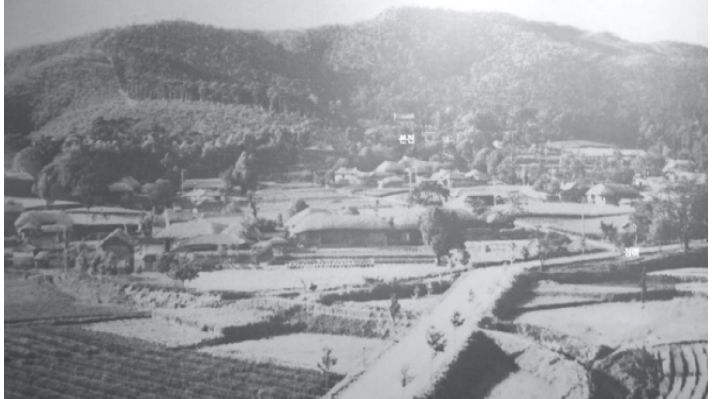
Figure 3. Panoramic View of Hyeonchungsa before its Reconstruction Project in 1966 (Source: Cultural Heritage Administration). Table 2. Details of the Presidential Directives on Hyeonchungsa in